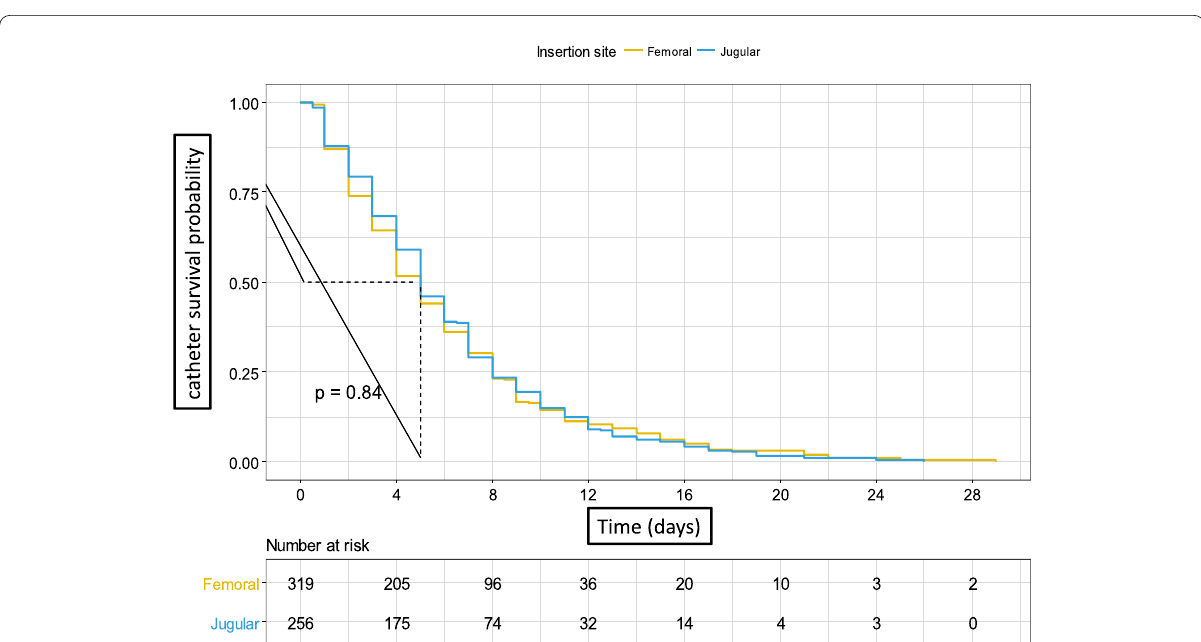
Fig. 2 Duration of catheter use. Legend: Median duration of use was 5 days for both femoral (IQR 2–8), and jugular (IQR 3–8) catheters ( p